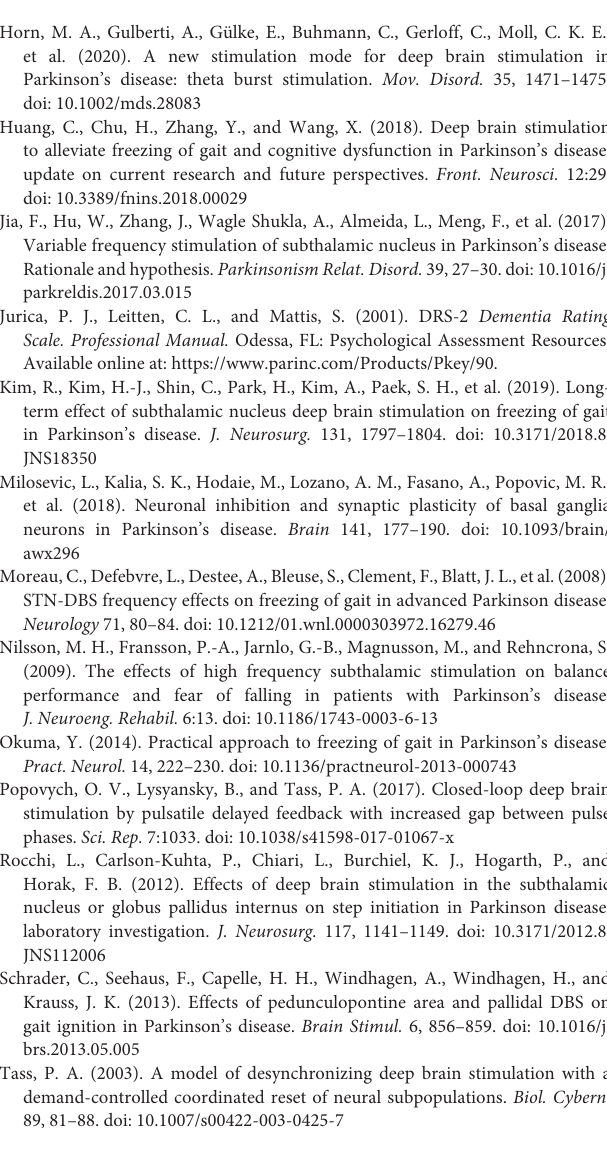
SUPPLEMENTARY FIGURE 1 | Motor outcomes from burst-cycling deep brain stimulation (BCDBS): the mean duration and standard error of the (A) Timed Up and Go Test and (B) modified video Unified Parkinson’s Disease Rating Scale (UPDRS) part III are plotted for all five conditions in the medication-OFF state. There were no significant differences among all five conditions. SUPPLEMENTARY FIGURE 2 | Gait metrics from BCDBS: the mean and standard error of the (A) gait cadence, (B) gait velocity, and (C) single support/double support % for both legs are shown for all five conditions in the medication-OFF state. Gait metrics were recording using the Zeno walkway gait-analysis system. There were no significant differences among all five conditions. LSS, left single support; LDS, left double support; RSS, right single support; RDS, right double